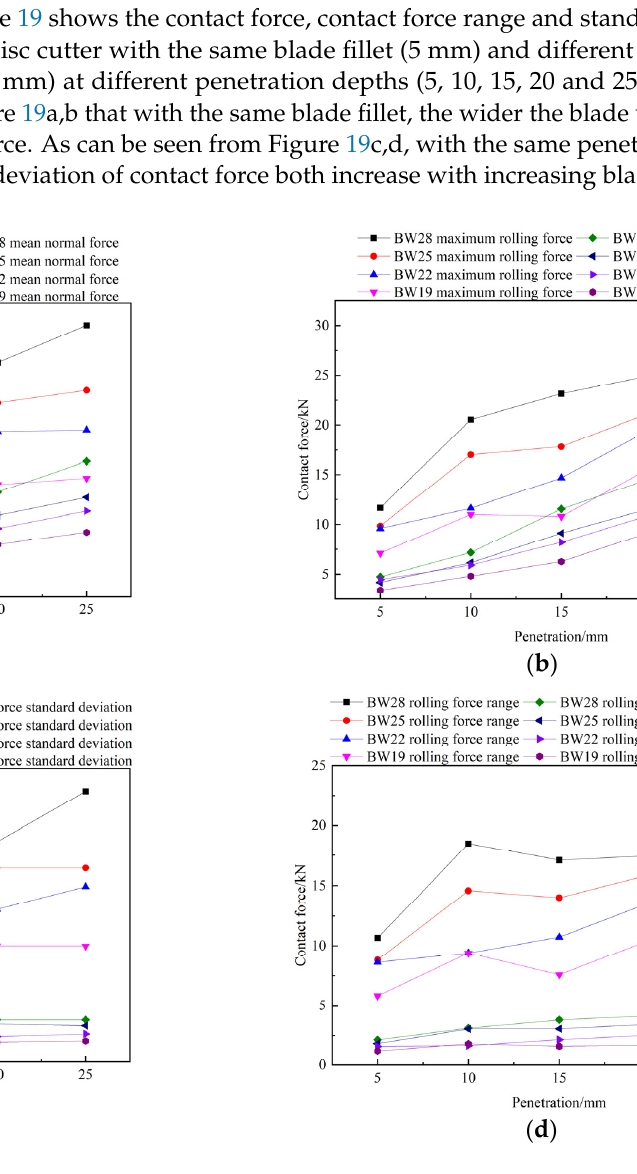
Figure 18. Stress contour of rock breaking by disc cutter with 22 mm blade width. ( a ) Stress contour of rock breaking (Blade fillet 0 mm); ( b ) Stress contour of rock breaking (Blade fillet 5 mm); ( c ) Stress contour of rock breaking (Blade fillet 9 mm).